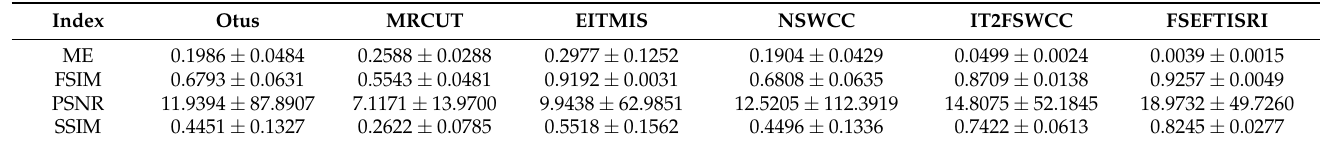
Table 4. Mean value and variance of evaluation indexes of several algorithms in BSDS.